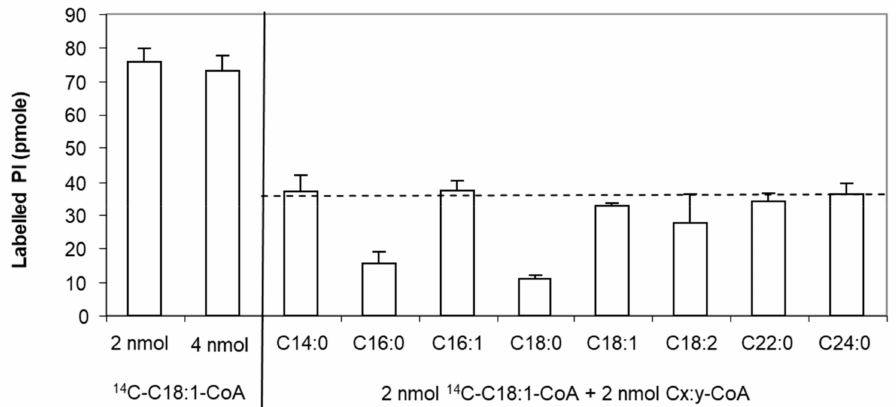
Figure 2. Determination of the acyl-CoA specificity. In vitro acylation of lyso -phosphatidylinositol was catalysed with membranes from E. coli transformed by pET-15b:: LPIAT plasmids (10 µ g protein / assay) corrected by the amount of labelled phospholipids obtained with membranes transformed by empty pET15b. Assays were carried out with 2 nmol of [ 14 C]-C18:1-CoA, 2 nmol unlabelled acyl-CoA and 4 nmol of LPI. After 10min incubation, lipids were extracted and analysed by TLC using chloroform / methanol / 1-propanol / methyl acetate / 0.25% aqueous KCl (10:4:10:10:3.6, v / v) as solvent followed by radioimaging. Values represent mean ± SD of 3 biological replicates with two technical replicates. The dashed line represents the theoretical level of labelled PI reached in presence of 2 nmol [ 14 C]-C18:1-CoA and 2 nmol